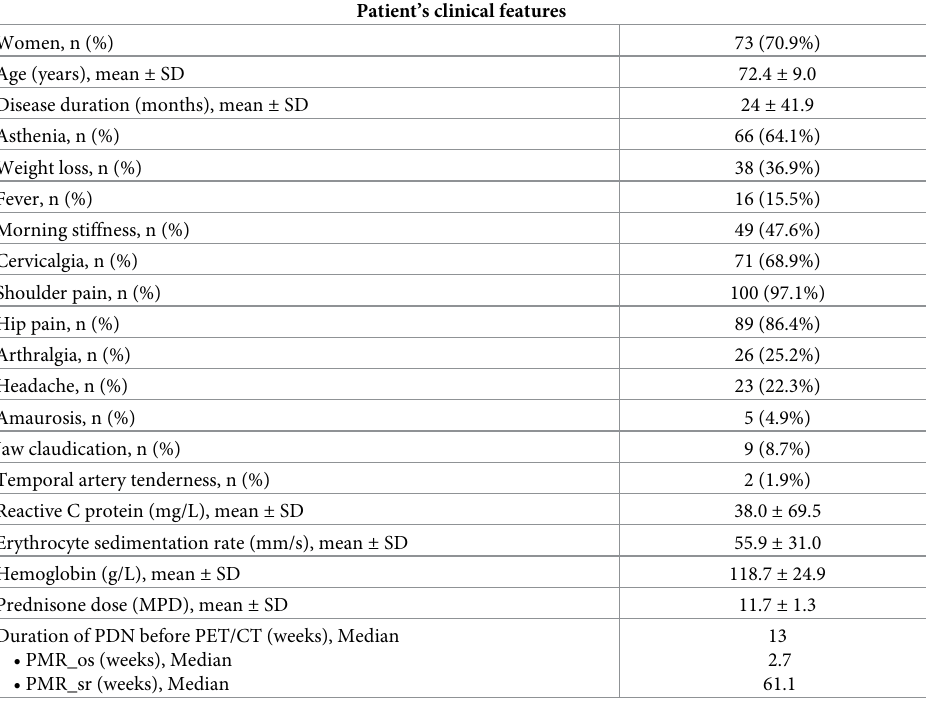
Table 1. Clinical characteristics of patients at the time of 18